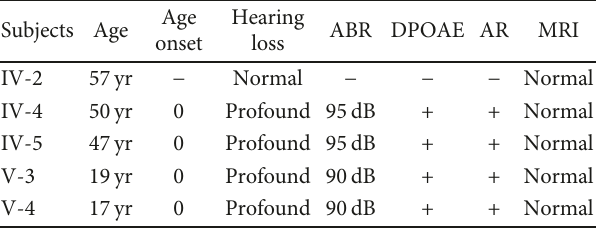
Table 1: Clinical features of the